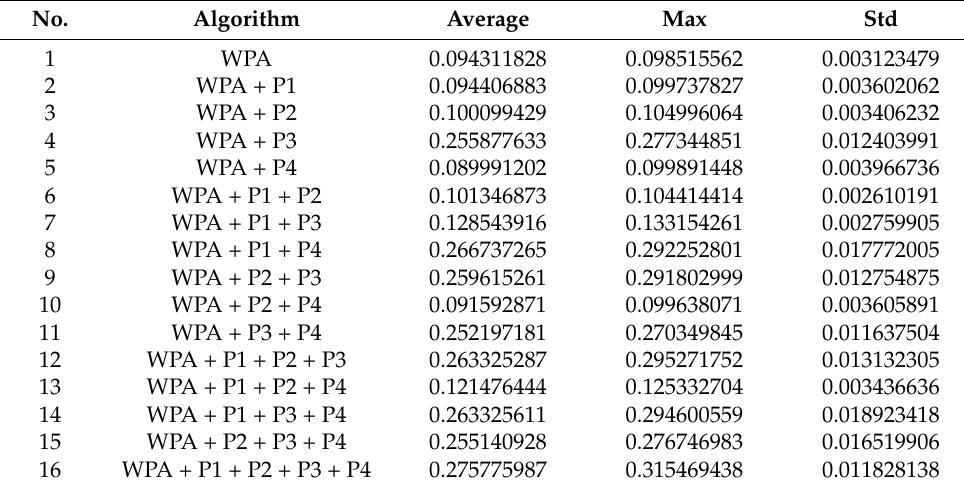
Table 4. The design scheme of orthogonal experiment design.